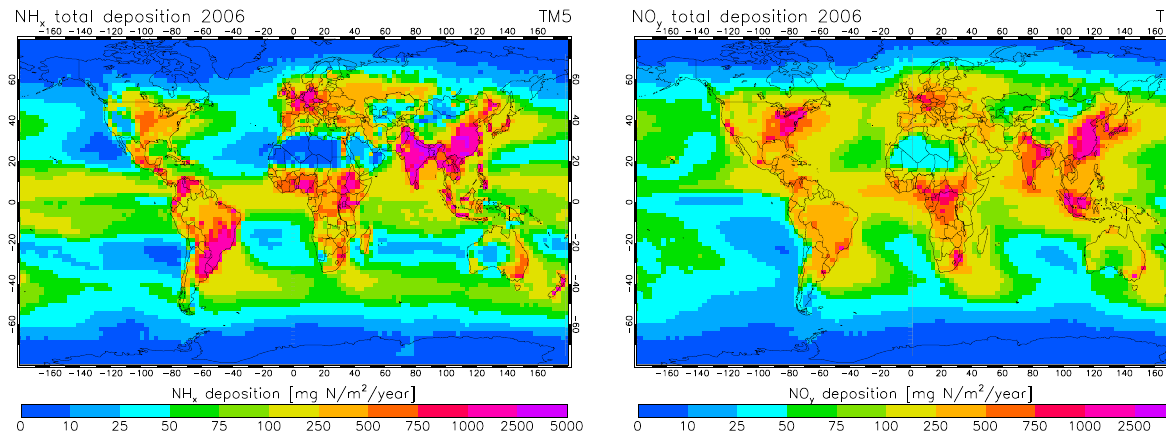
Fig. 12. Annual NH x and NO y dry and wet deposition in TM5 for 2006.